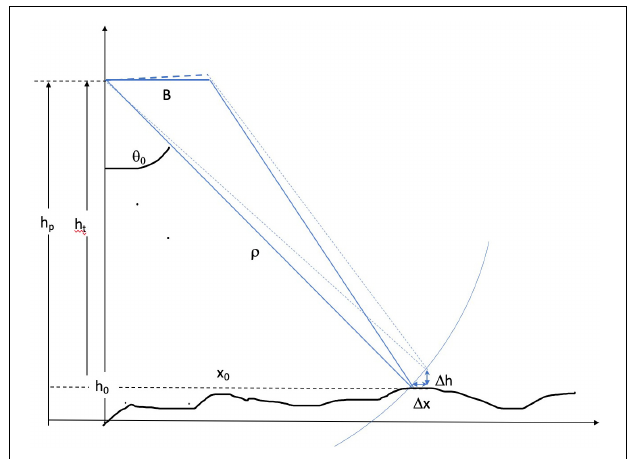
FIGURE 2 | Interferometric geometry illustrating how a slope can be introduced in the measured surface due to imperfect geometry knowledge of the baseline angle